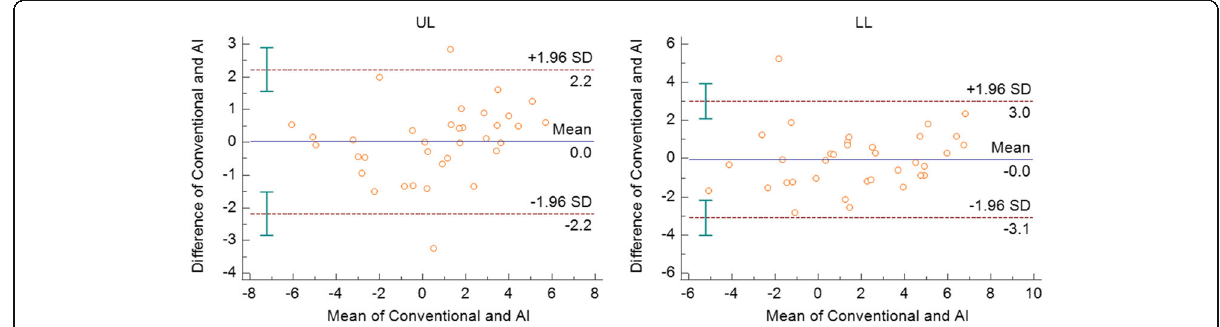
Fig. 4 Bland-Altman plots for the soft tissue measurements in each conventional and AI